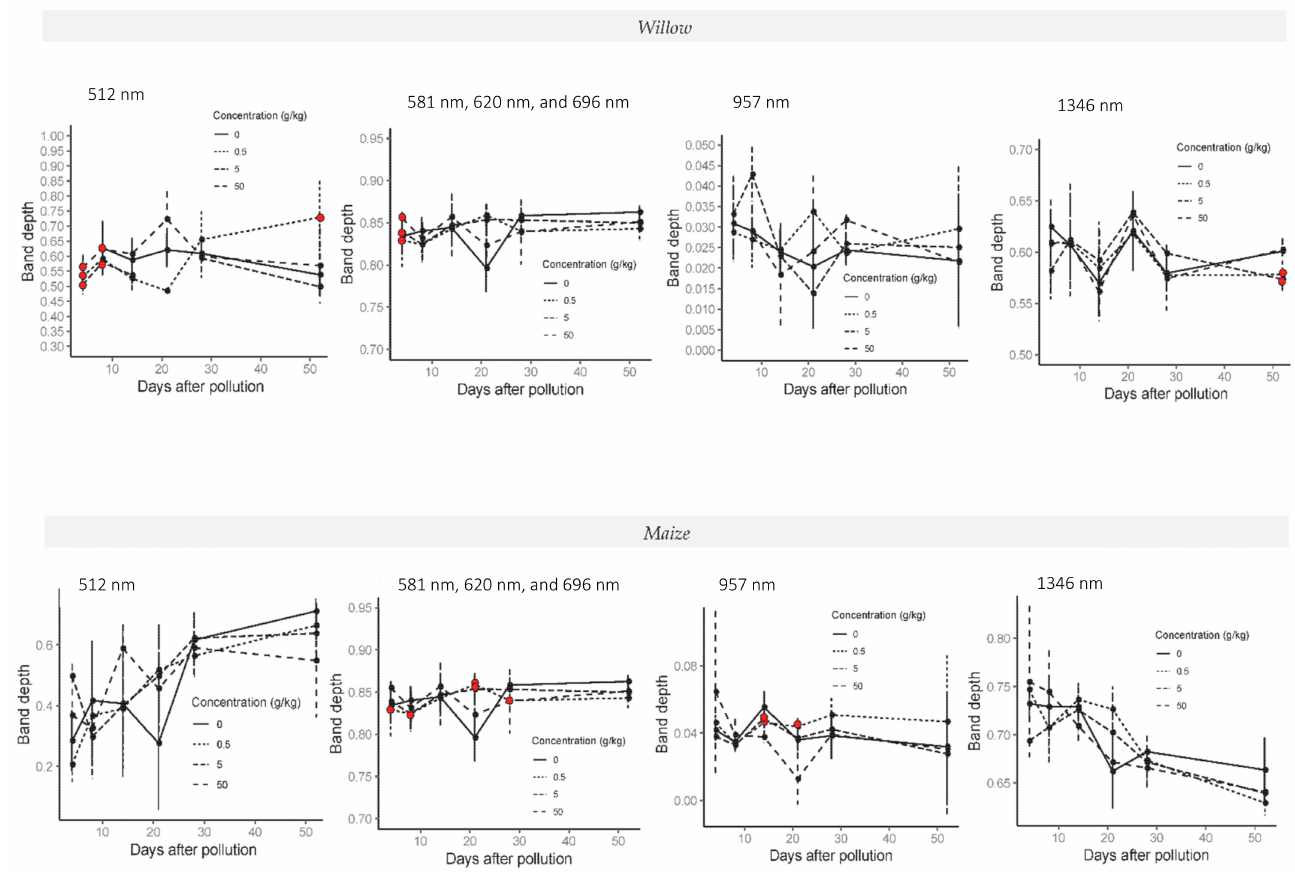
Figure 7. Band depth time series in 512, 620, 957, and 1346 nm absorption features in willow (top line charts) and maize plants (bottom line charts) during the whole experiment in crude oil treatments. Red dots indicate the treatments with significant differences relative to the control treatment. Last spectral measurement of willow was 52 days after the addition of the pollution and last day in the maize experiment was 50 days after the addition of the